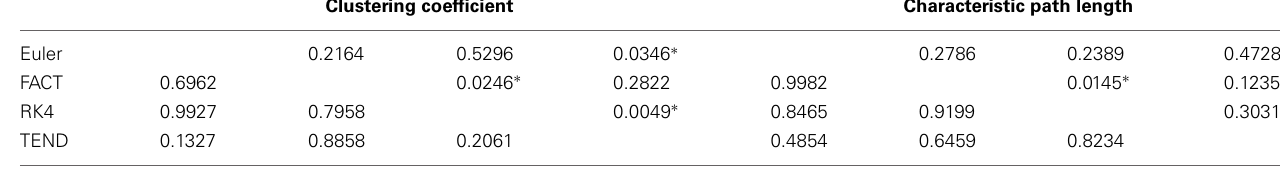
Table 2 | Functional data analysis is used along with permutation testing to look for pair-wise differences in graph-metric vs. graph-density curves that result from different fiber tracking algorithms and label sets.